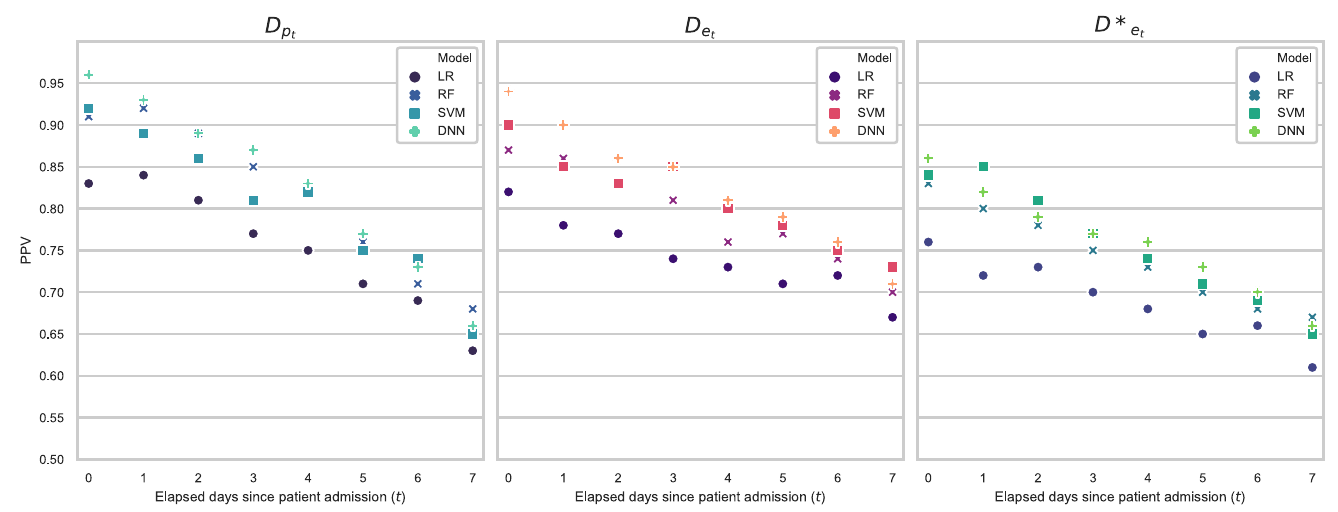
Fig 3. PPV results. Scatter plots giving the PPV, calculated for the 20% of patients with the highest positive classification scores, for LR, RF, SVM and DNN models, trained and tested on the different sub-datasets which reflect the patient cohorts at different points in their hospital stays. Planned admissions are represented by D pt , emergency admissions D and emergency admissions with an infectious disease D � . et et https://doi.org/10.1371/journal.pone.0260476.g003 to prioritise for a secondary screening. Four different model architectures, LR, RF, SVM and DNN, were compared in their abilities to make this classification. Planned and emergency admissions within the dataset were studied separately, with custom models developed for each. The predictions were made for each day of a patient’s admission, from the first day of their arrival up to 7 days into their stay. It was found that the DNN models often outperformed the other models considered.